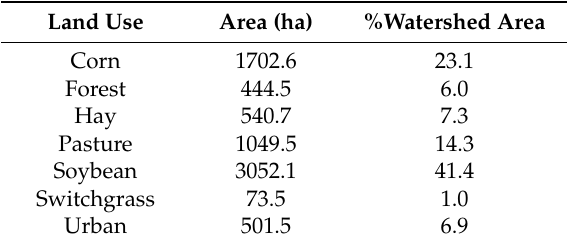
Table 1. Land use land cover for the Goodwater Creek Experimental Watershed based on NASS